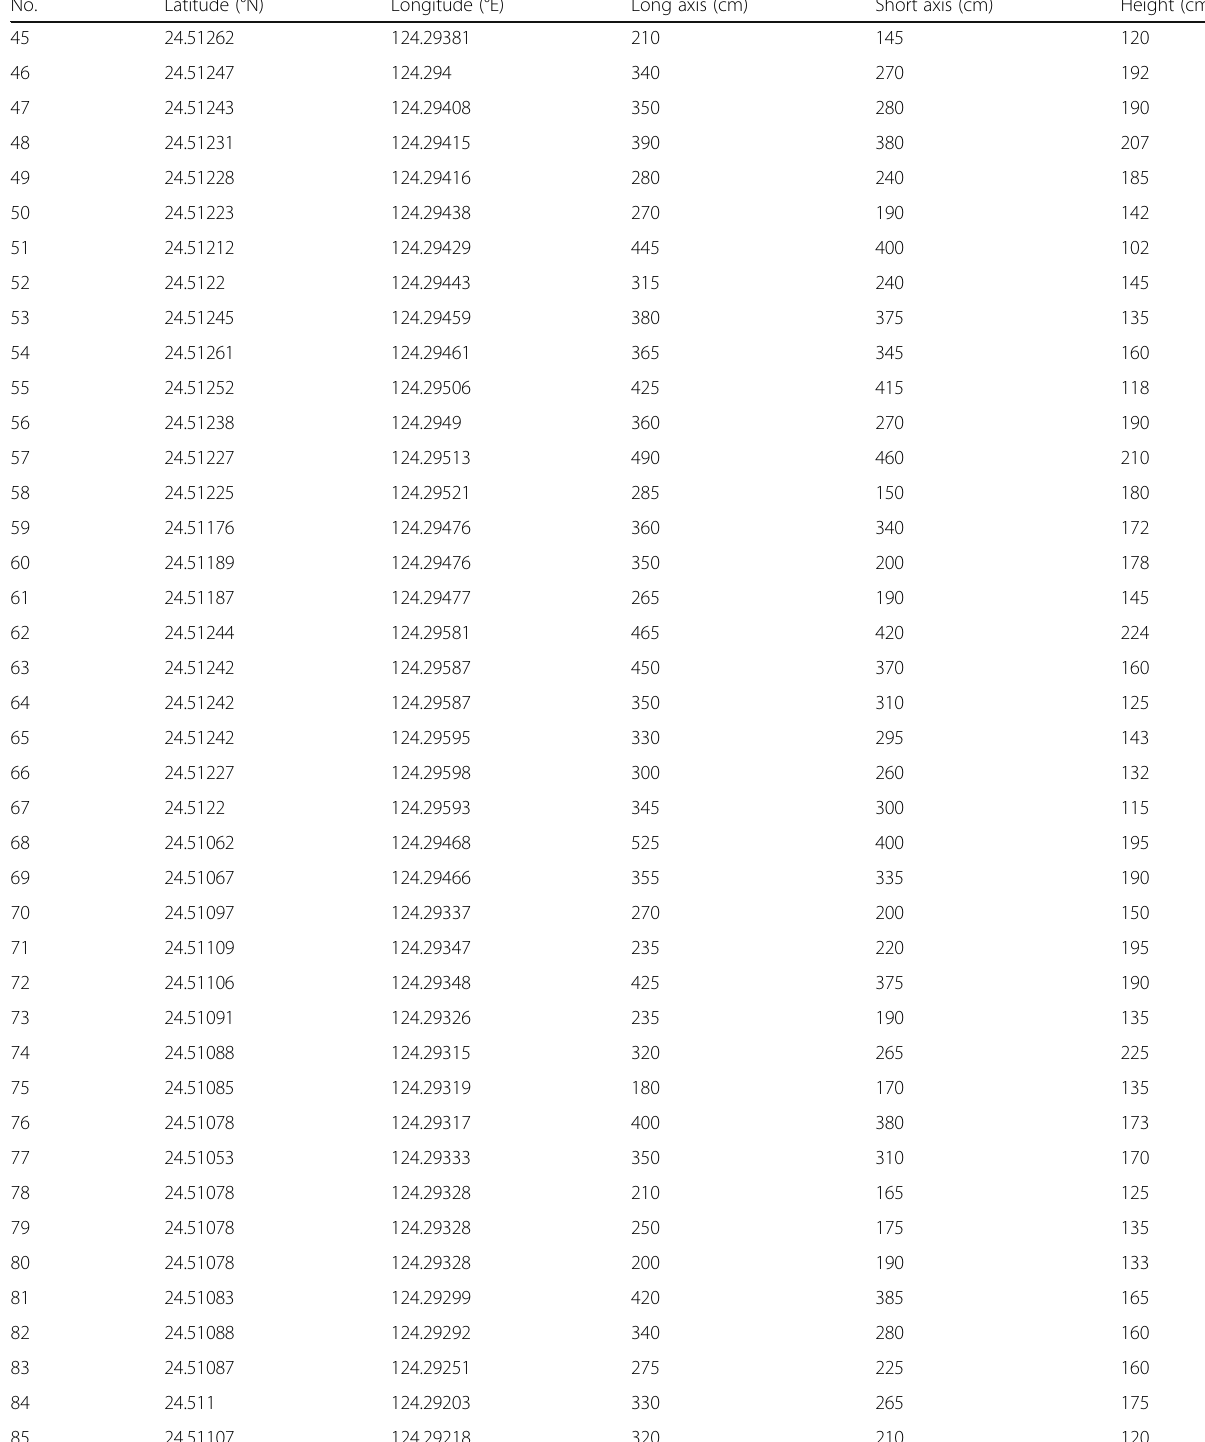
Table 1 Locations and three dimensions of measured living massive corals